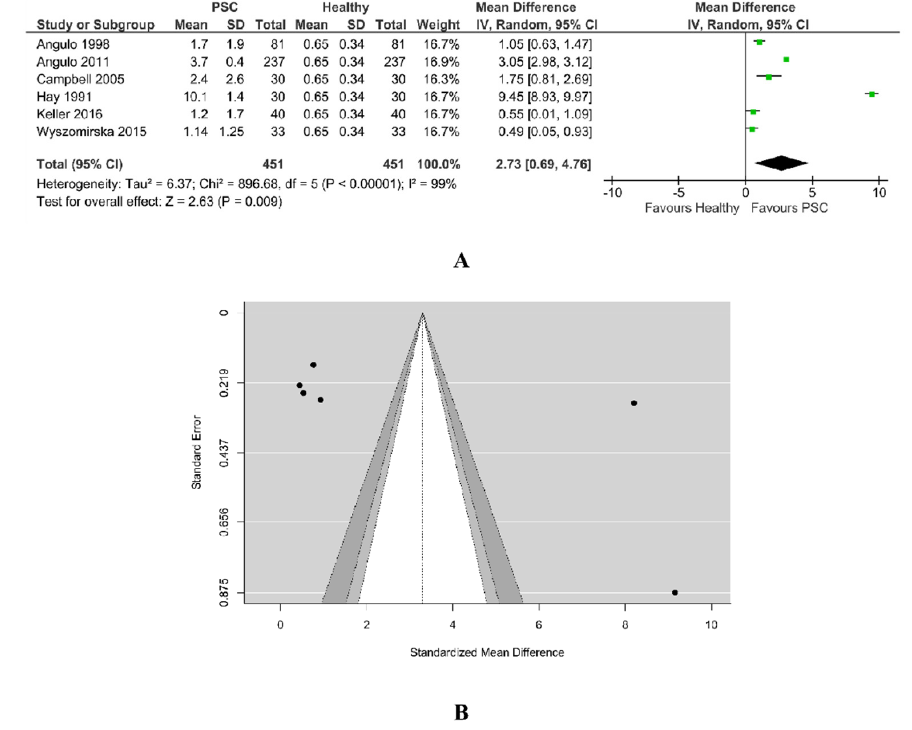
Figure 9. ( A ) Forest plot assuming a random-effects model for bilirubin PSC vs. Healthy. ( B ) Funnel plot for publication bias assessment for bilirubin in PSC patients vs. Healthy [18,19,29,31,32,34]. Both Rank correlation test (value = 0.867, p = 0.017) and Egger’s regression test (value = 2.134, p = 0.033) indicated potential funnel plot asymmetry, as in Figure 9B.